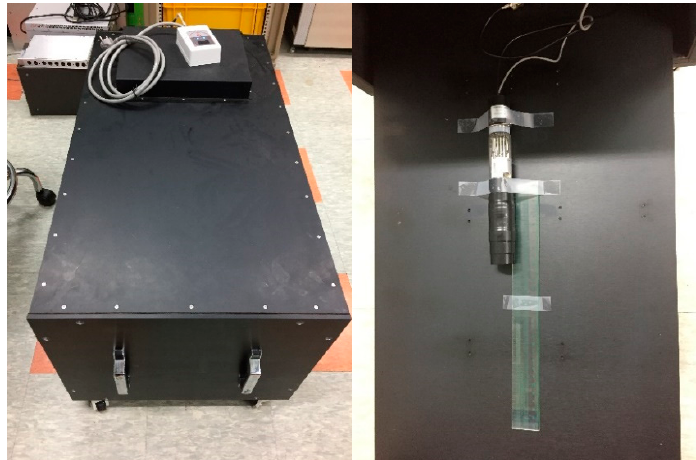
Figure 2. Aluminum dark box and experimental set-up.